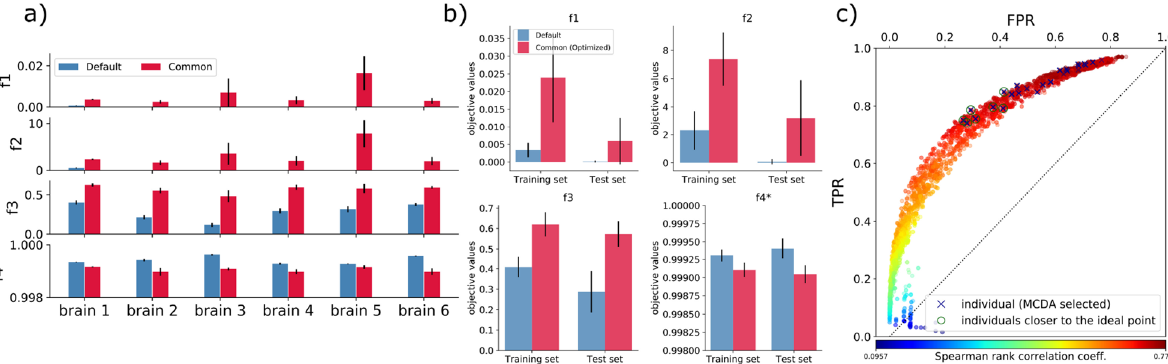
Figure 6. Performance on test data and region-level connectomes. ( a ) Objective function comparison (average values for 5 runs) for 6 additional marmosets shows improvement of f 1 , f 2 and f 3 , and consistency of f ∗ 4 . ( b ) Performance comparison between training and test data sets for the default and optimized settings. f 3 is the most improved objective; however, improvement of f 1 and f 2 contributed to better results, as well as f ∗ 4 consistency for denser tractograms. ( c ) Spearman’s rank correlation coefficient (color coded) mapped onto TPR - FPR space, from comparisons of 20 × 500 neural tracer- and tractography-based matrices, for the entire optimization process. Optimized tractography results (dark blue x’s) closer to the ideal ROC coordinate (green circles) show high